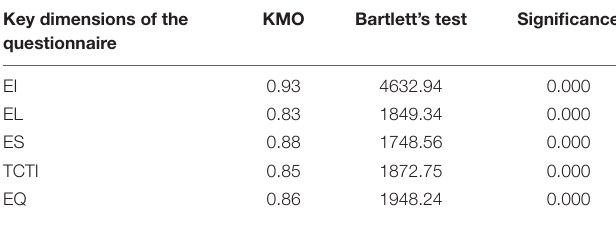
TABLE 3 | Results of the validity analysis of the